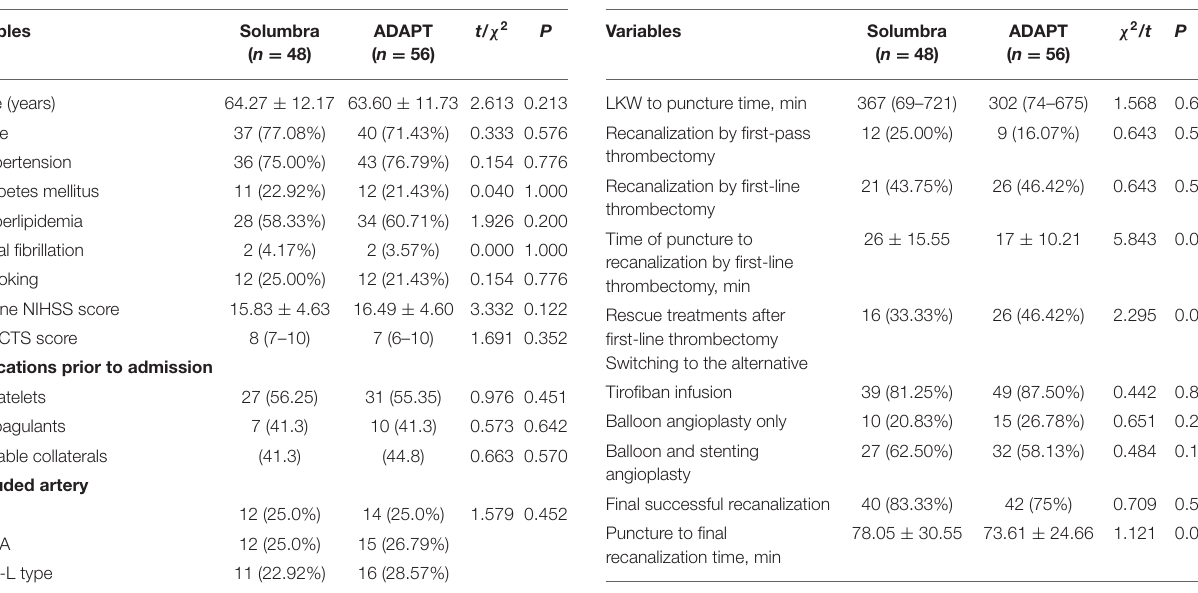
TABLE 1 | Demography and clinical data. TABLE 2 | Radiologic outcomes of endovascular treatment.